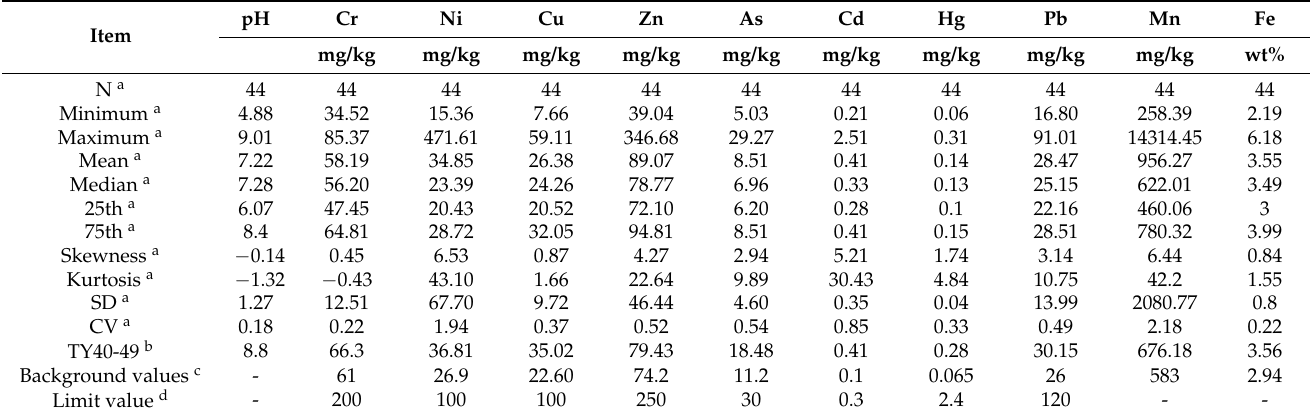
Table 1. pH and concentration of metals in soil samples of coal mine area.